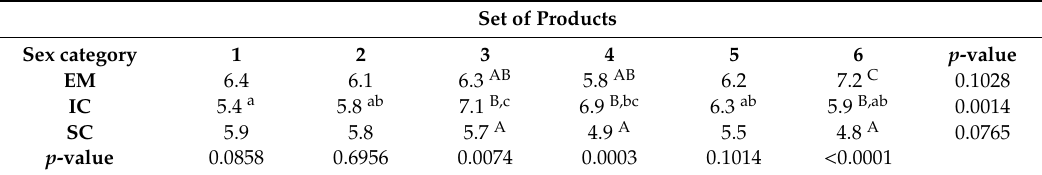
Table 3. Least squares mean (LSM) for sensory acceptability according to the sex category and set of products.